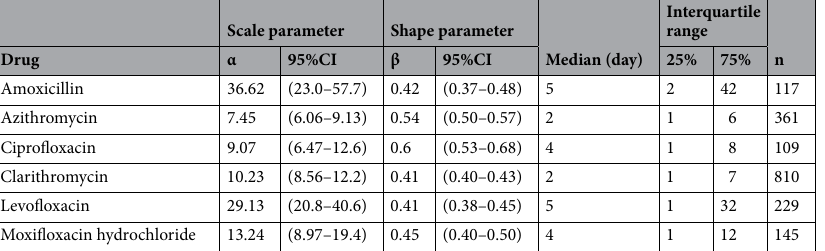
Table 3. β by fitting of weibull distribution. The calculated β was below 1, and the 95% CI did not include 1. The occurrence of these antibiotic-induced taste and smell disorders was presumed to be an early failure type that is likely to occur early.